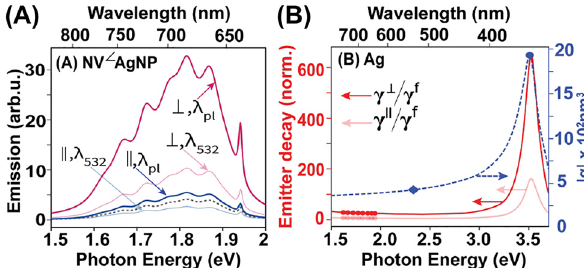
Figure 4: The impact of illuminating at plasmon resonance. (A) Total near-field emission of NV centers in NV ⊥ AgNP ( ∠ → ⊥ ) and NV ‖ AgNP ( ∠ → ‖ ) setups in air illuminated at the input wavelength 532 nm ) and at the plasmon resonance wavelength of the adjacent ( 𝜆 532 = 7 nm and the NV-AgNP center ). The AgNP radius r AgNP ( 𝜆 pl m separation R = 12 nm. The submerging medium is air. (B) The right y -axis shows the absolute polarizability | 𝛼 | of the r m = 7 nm AgNP in air. The blue diamond and circle depict the values of the input and 𝜆 , respectively. The laser energies when illuminated at 𝜆 532 pl estimated decay rates for generic emitters oriented radially ( ⊥ ) and tangentially ( ‖ ) to the surface of the same AgNP, normalized by the respective free-space decay rates 𝛾 f ( 𝜔 ), are shown on the left y − axis. Red and pink circles depict the values at NV emission peaks, for NV ⊥ AgNP and NV ‖ AgNP orientations,